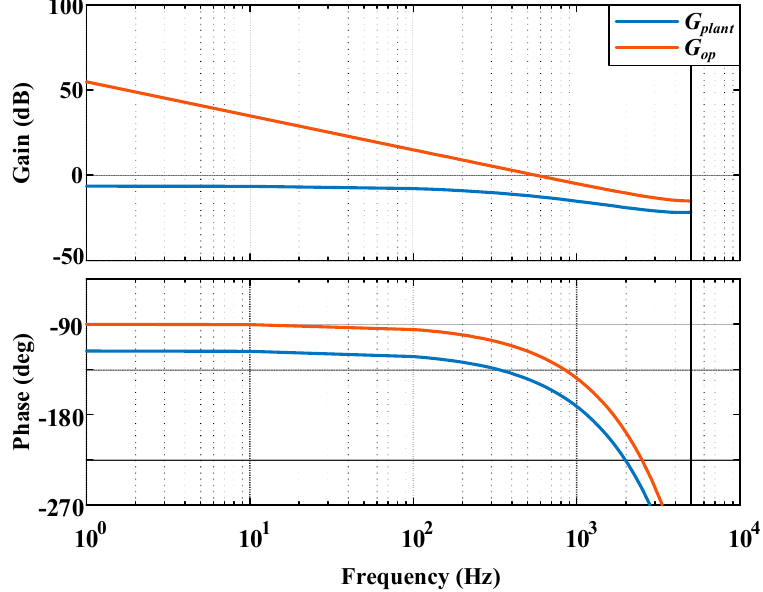
Figure 15. The bode diagram of G plant and G op .